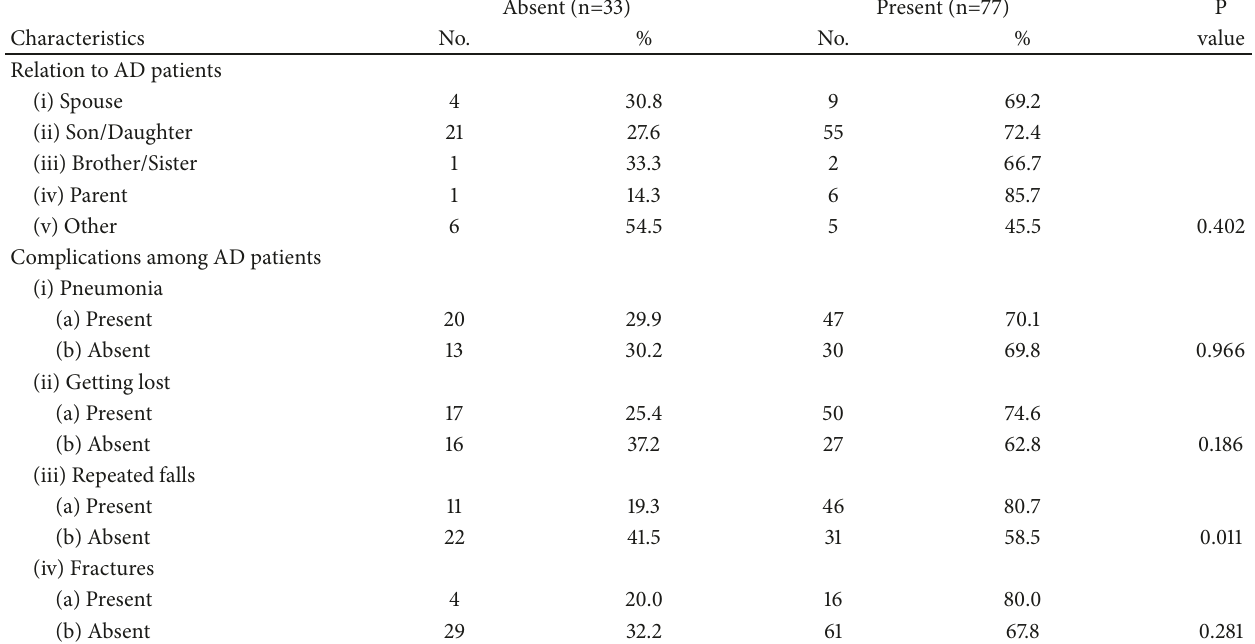
Table 4: Prevalence of depression among caregivers according to characteristics of AD patients.